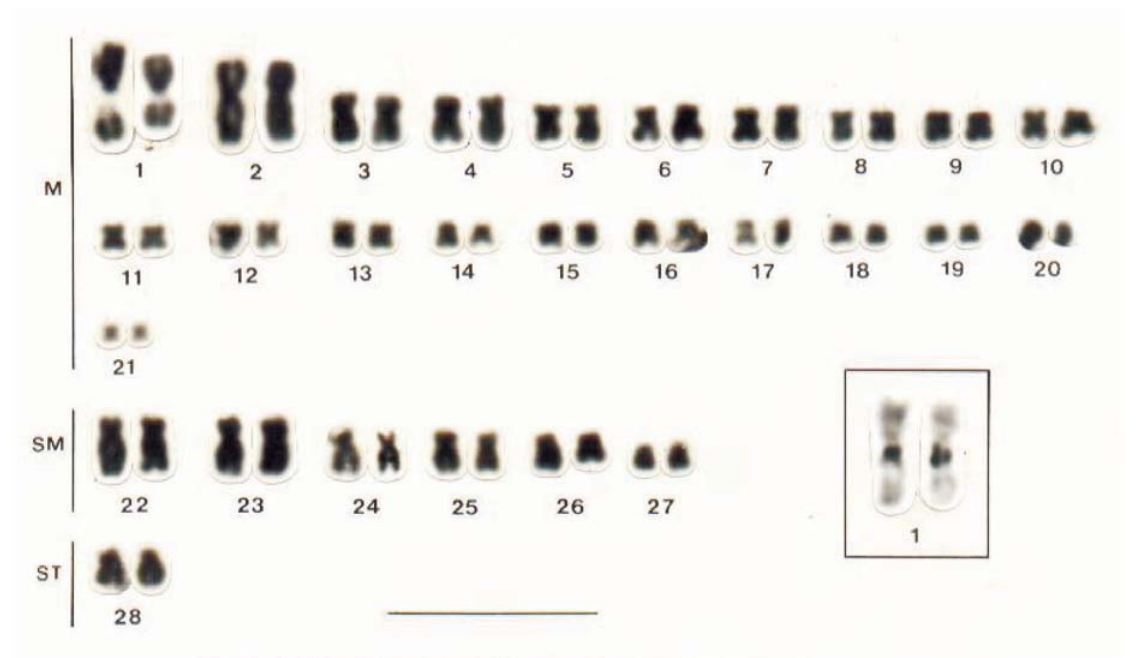
Fig. 2. Karyotypic macrostructure of Trichomycterus diabolus . In detail the NOR-bearing chromosome pair after silver staining. M=metacentrics; SM=submetacentrics; ST=subtelocentrics chromosomes. Bar = 10